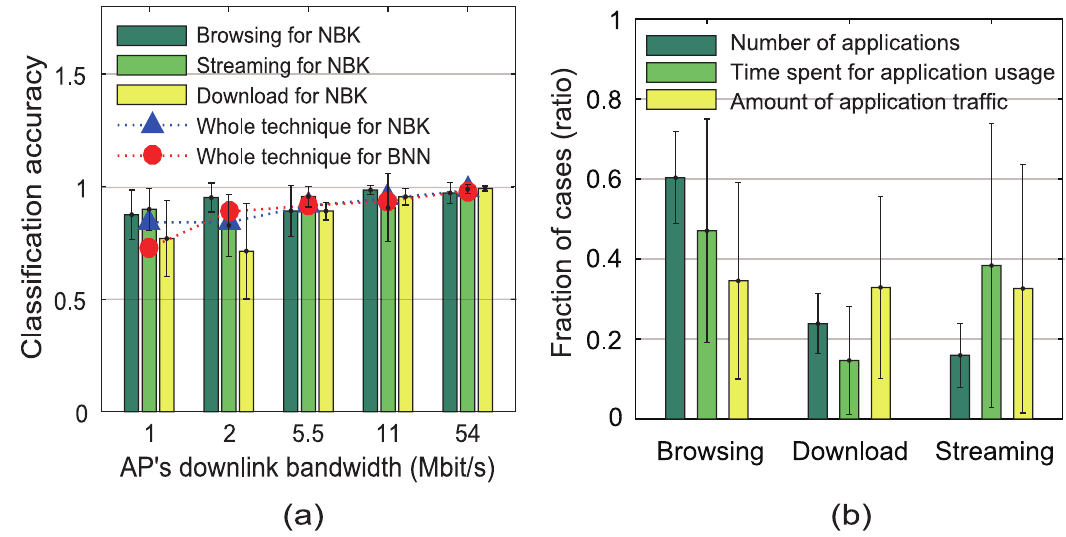
Fig 9. Classification accuracy and application usage patterns. (a) accuracy of our classifiers versus the AP’s downlink bandwidth and (b) the analysis of application usage for each type per user.